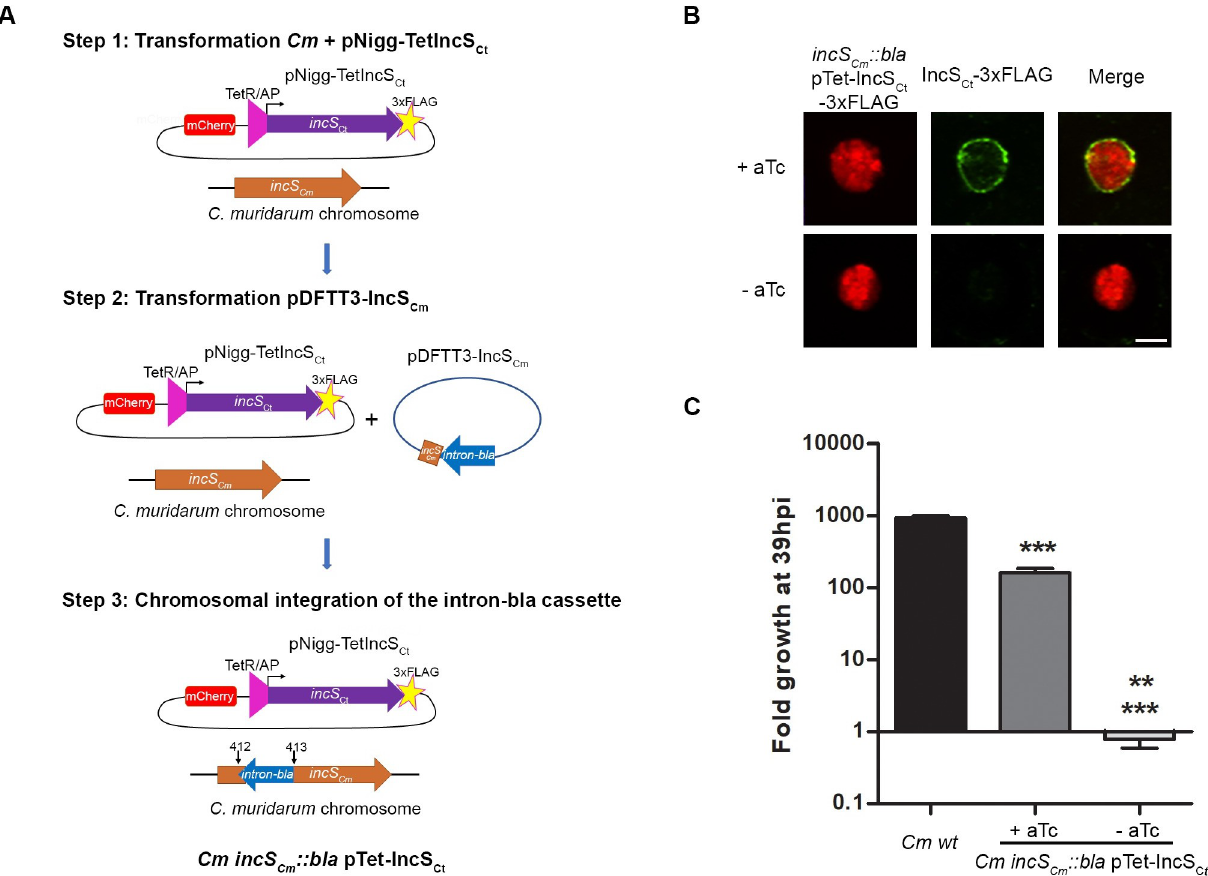
Fig 3. Chlamydia muridarum incS conditional mutant displays a severe growth defect in cell culture. (A) Schematic representation of the modified 3-step Targetron strategy used to generate a C . muridarum incS ( tc0424 ) conditional mutant ( Cm incS :: bla pTet-IncS Ct ). Step1: Transformation of Cm Cm wild-type C . muridarum , containing an intact chromosomal incS Cm ORF (brown), with pNigg-Tet-IncS Ct , a complementation plasmid encoding mCherry (red) and a 3x-FLAG tagged (yellow star) allele of IncS Ct (purple) under the control of aTc inducible promoter (TetR/AP, pink triangle). Step 2: Transformation of the strain resulting from step 1 with pDFTT3-IncS Cm harboring genetic elements to facilitate the insertion of a group II intron and the ß-lactamase gene at nucleotide position 412 of the incS Cm ORF ( intron-bla , blue arrow). Step 3: Expression of IncS Ct from the complementation plasmid, allows for integration of the intron-bla cassette and interruption of the incS ORF. (B) Single plane confocal micrographs of HeLa cells infected for 18h Cm with the Chlamydia muridarum Δ incS Cm :: bla conditional mutant expressing mCherry ( incS Cm :: bla pTet-IncS Ct -3xFLAG, left panels, red) in the presence (+aTc, top panels) or the absence (-aTc, bottom panels) of aTc and stained with anti-FLAG antibody (IncS Ct -3xFLAG, middle panels, green). The merge is shown on the right. Scale bar: 5 μ m. (C) Fold growth of wild-type C . muridarum ( Cm wt ) and the Chlamydia muridarum Δ incS Cm :: bla conditional mutant ( incS :: bla pTet-IncS Ct ) in HeLa cells at 39h pi compare to 0h pi in the presence (+aTc) or absence (-aTc) of aTc. Data are mean ± SEM, three Cm combined experiments, One-way ANOVA, Tukey’s Multiple Comparison Test, �� P < 0.01 (-aTc vs + aTc); ��� P < 0.001 (-aTc vs